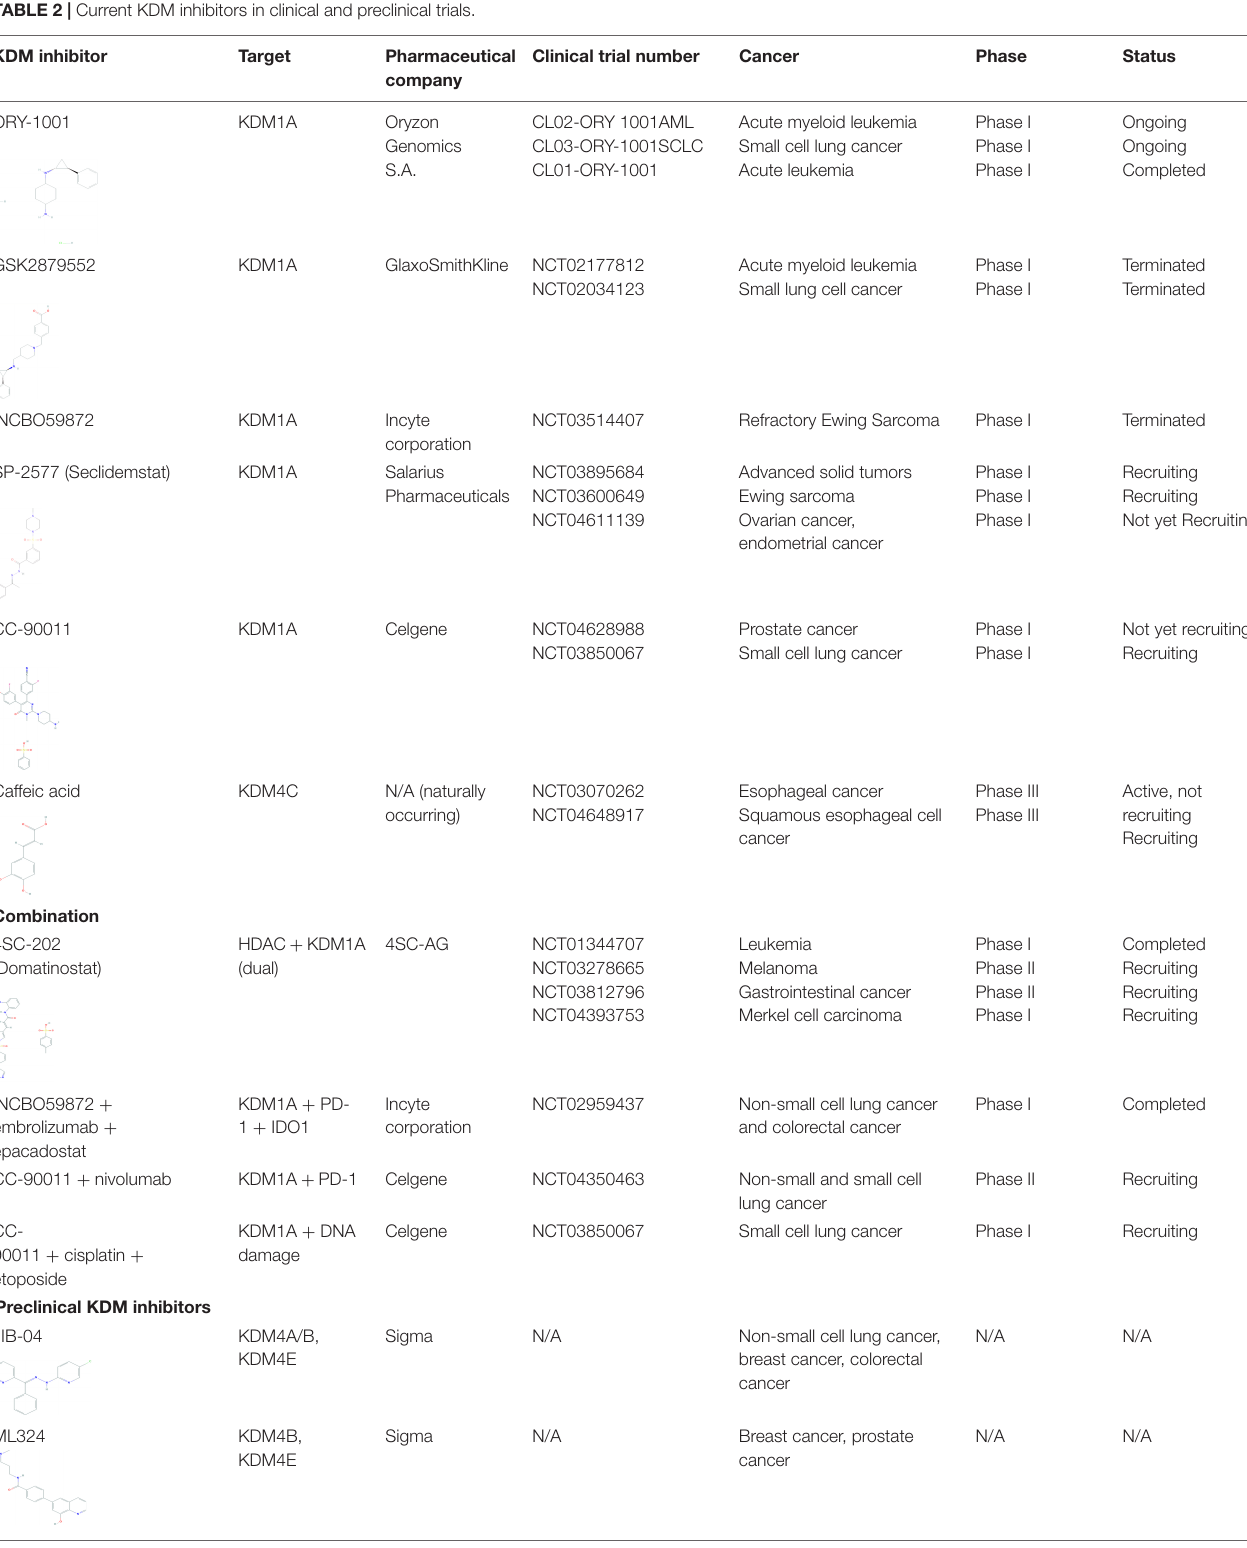
TABLE 2 | Current KDM inhibitors in clinical and preclinical